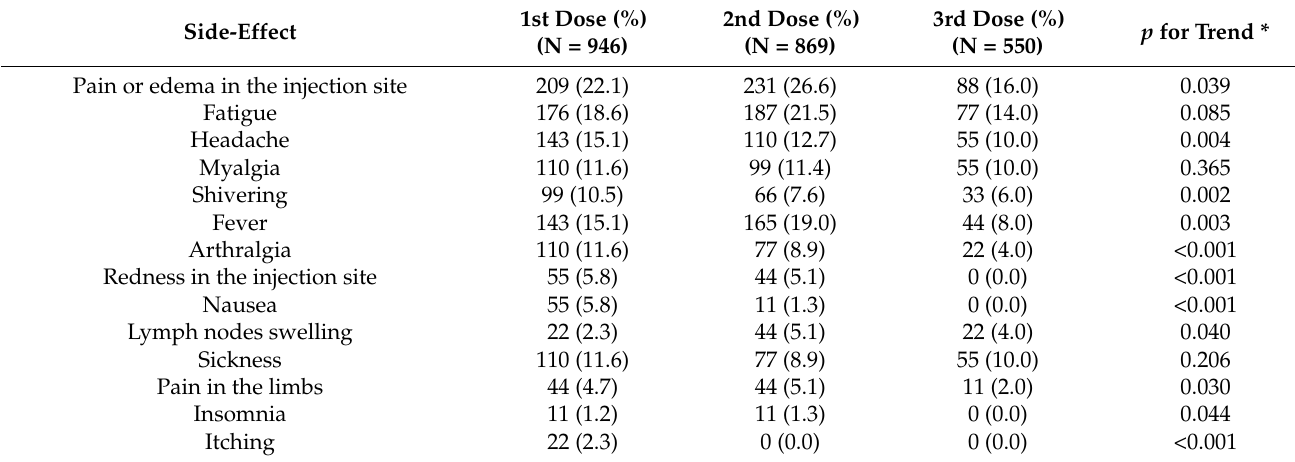
Table 5. Main side-effects of SARS-CoV-2 vaccination reported by the athletes.